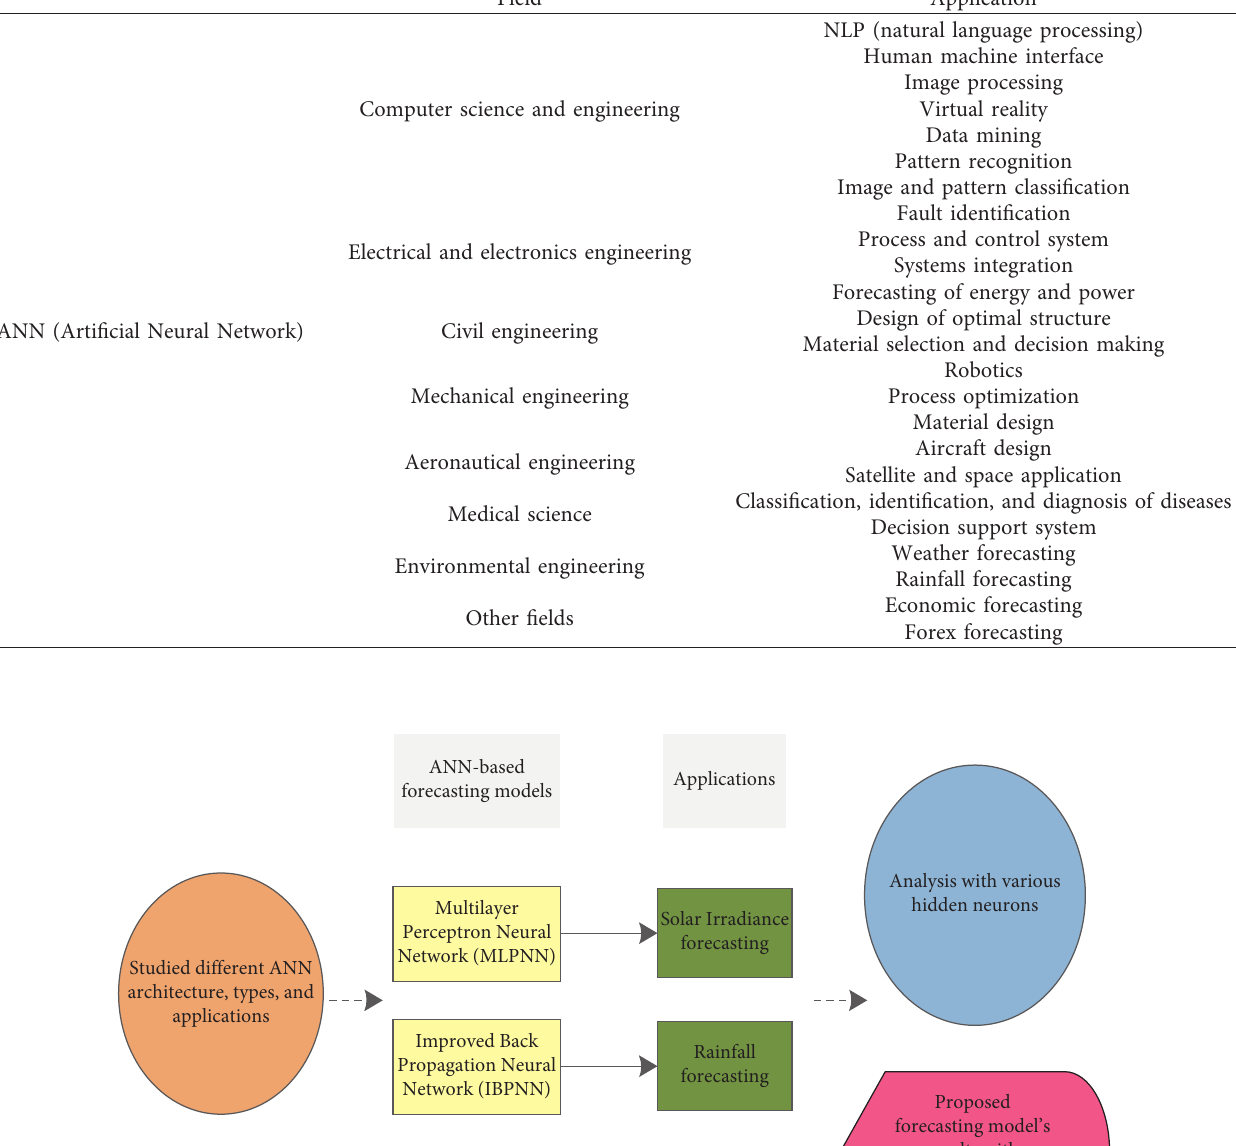
Table 2: Applications of ANN in various fields.